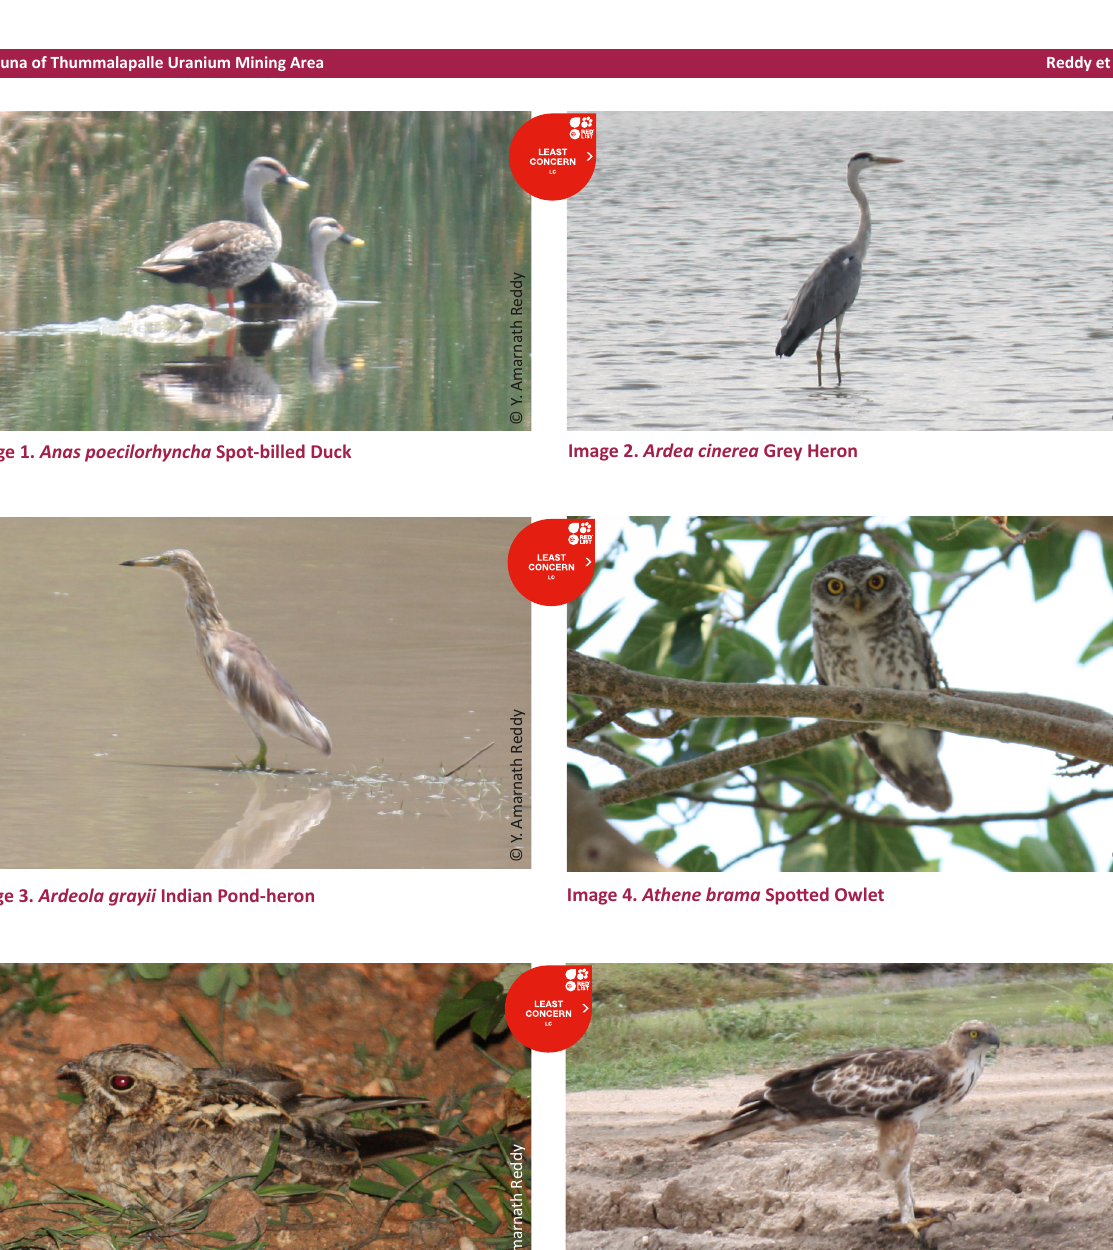
Image 5. Caprimulgus asiaticus Common Indian Nightjar